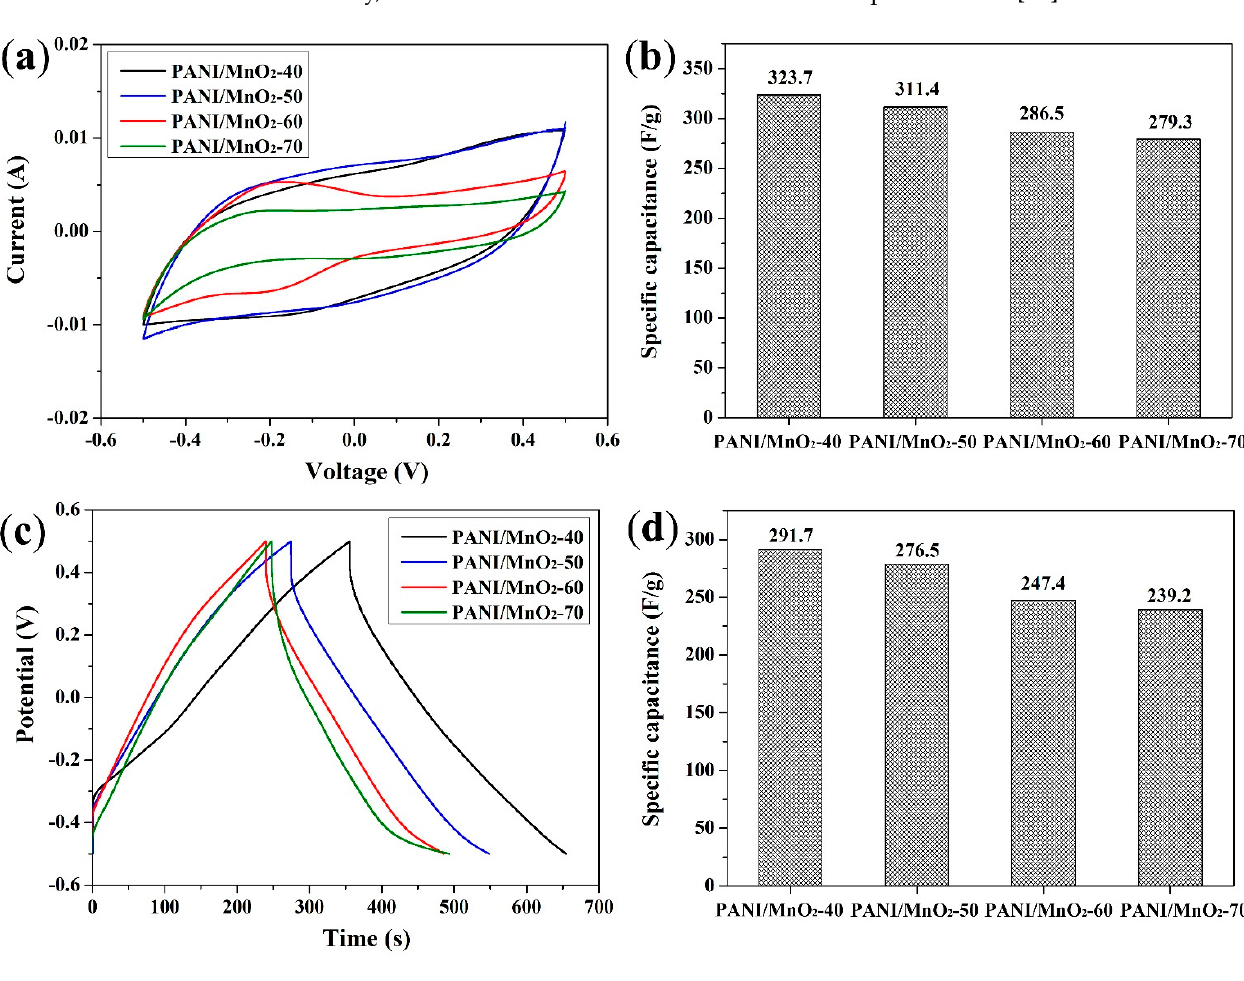
Figure 9. PANI/MnO 2 composite: ( a ) CV profiles at the scan rate of 5 mV/s, ( b ) the plot of specific capacitance at the scan rate of 5 mV/s, ( c ) GCD profiles at the current density of 1 A/g, ( d ) the plot of specific capacitance at current density of 1 A/g.